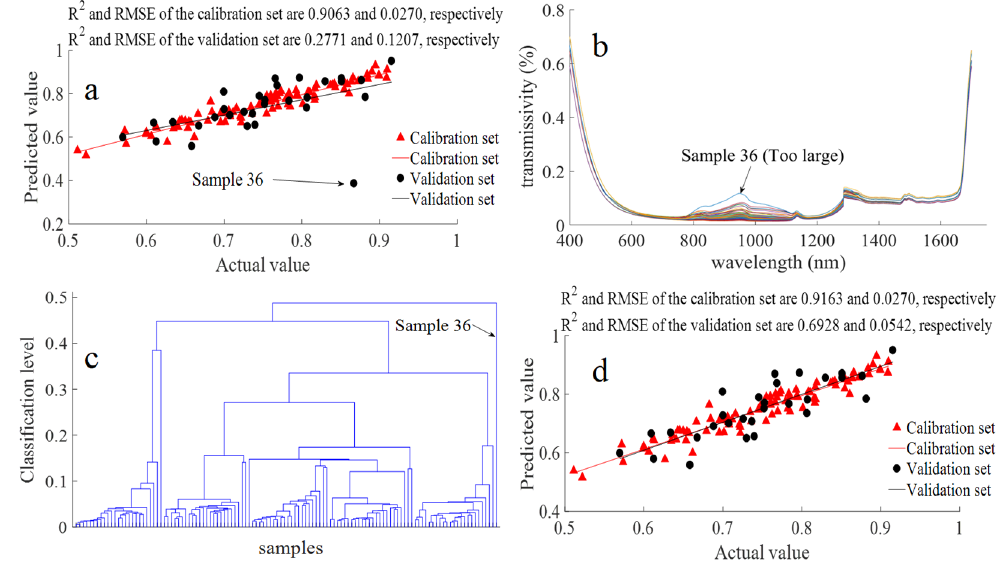
Figure 3. Pomelo water content detection based on the spectral raw data and singular sample elimination: ( a ) partial least squares regression (PLSR) analysis result based on all data, ( b ) differences betweenthe raw data of all samples, ( c ) singular sample discovery based on Euclidean distance clustering, and ( d ) PLSR analysis resultbased on singular sample eliminated data.